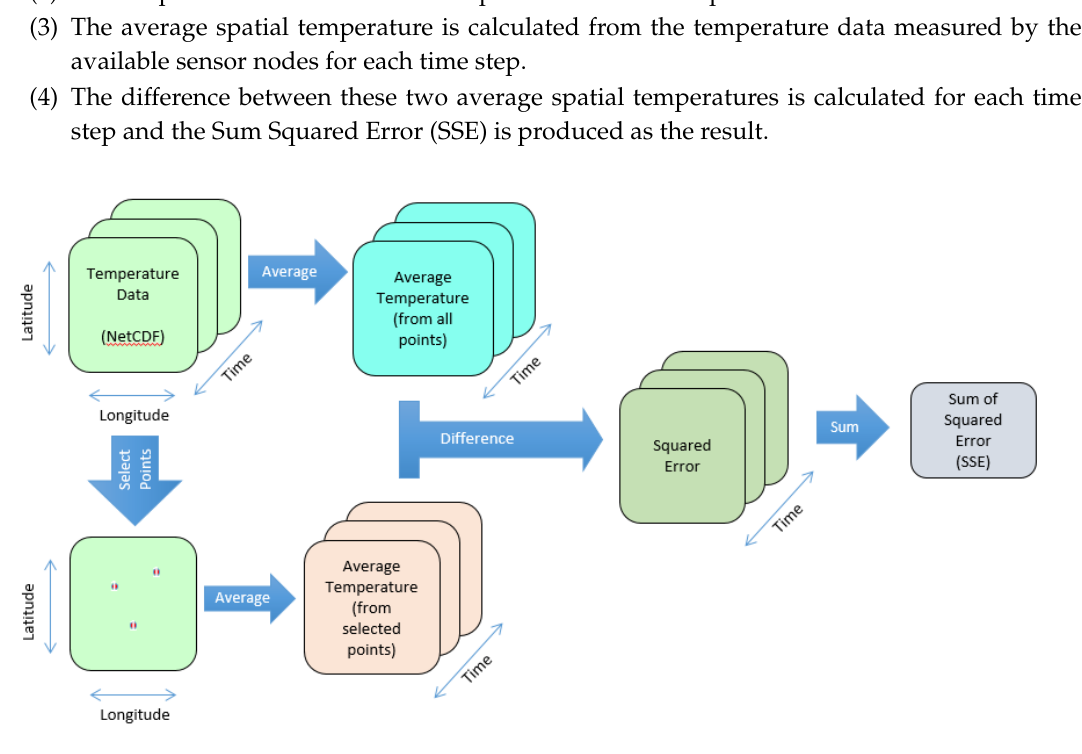
Figure 3. The figure shows the work flow to measure the representativeness of an ESN in respect to the Region of Interest (RoI) based on the average spatial temperature. The representativeness is calculated according to the difference between the actual average spatial temperature and the average spatial temperature measured by the deployed sensor nodes over periods of